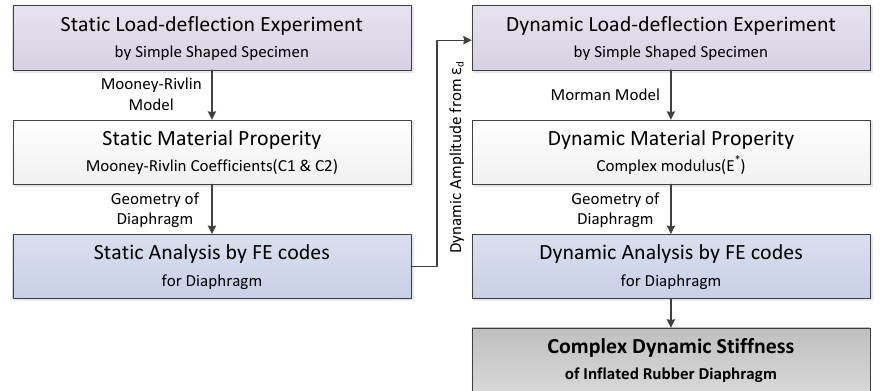
Figure 2. Estimation procedure of the dynamic complex stiffness of the diaphragm using finite element method.